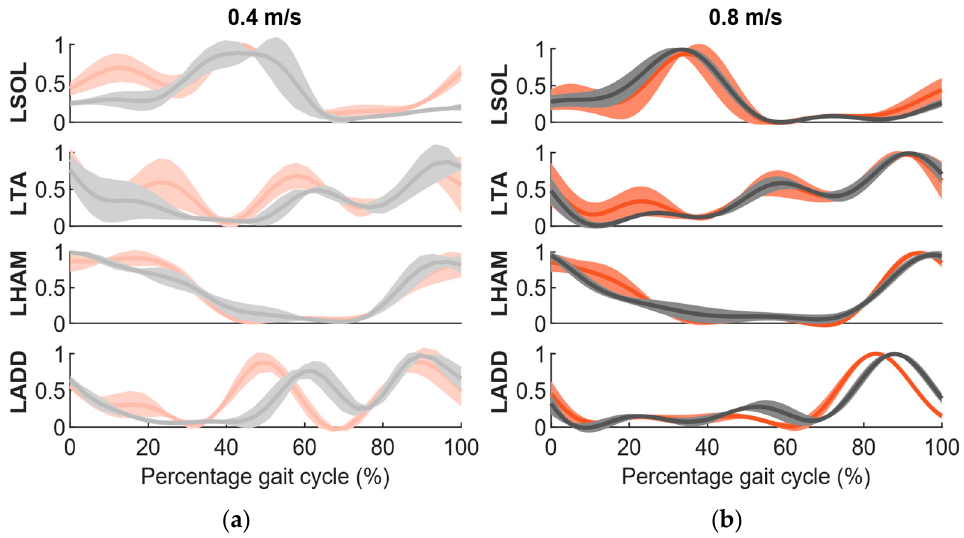
Figure 2. EMG signals for a selection of muscles of a representative subject for inward-directed perturbed (orange) and unperturbed (grey) ( a ) slow and ( b ) fast walking. Perturbation onset was 0% of the stance phase of the gait cycle. EMG signals are shown as the mean (solid line) ± standard deviation (shaded area) of three trials. LSOL, left soleus; LTA, left tibialis anterior; LHAM, left hamstring; LADD, left hip adductor.